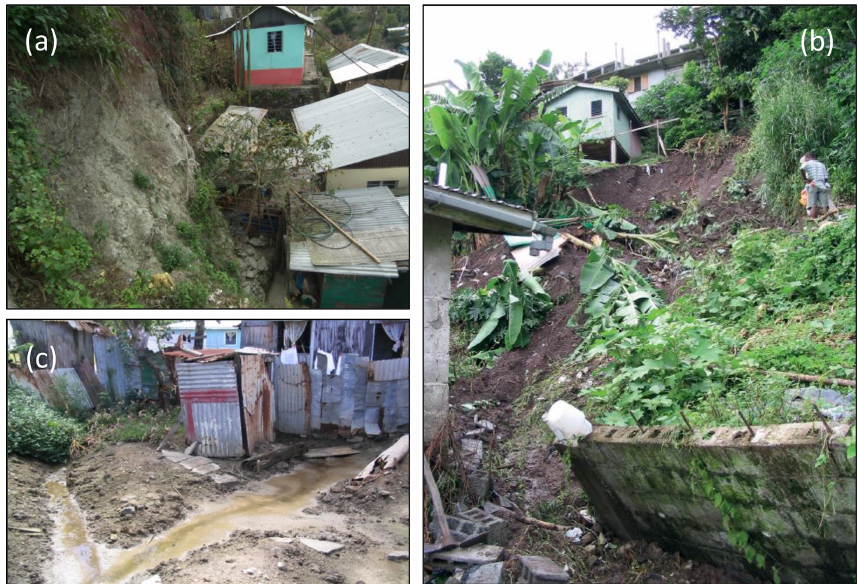
Figure 1. Examples of informal housing affecting land stability. Panels (a) and (b) show examples of unsupported cut slopes, respec- tively, in Dumsi Pakha (Kalimpong, India) and Saint Lucia (Caribbean). Panel (c) shows the effect of the lack of water management in an informal community of Saint Lucia (Caribbean). From the AGU Landslide Blog (https://blogs.agu.org/landslideblog/2016/03/14/ managing-urban-landslides-1/, last access: 21 November 2020) and the community-based project Mossaic (Management of Slope Stability In Communities; Anderson and Holcombe,